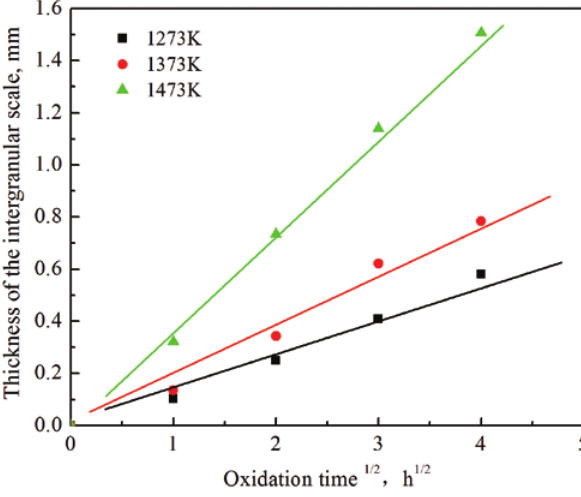
Fig. 10: Relationships between the thickness of the intergranular scale and the square root of oxidation